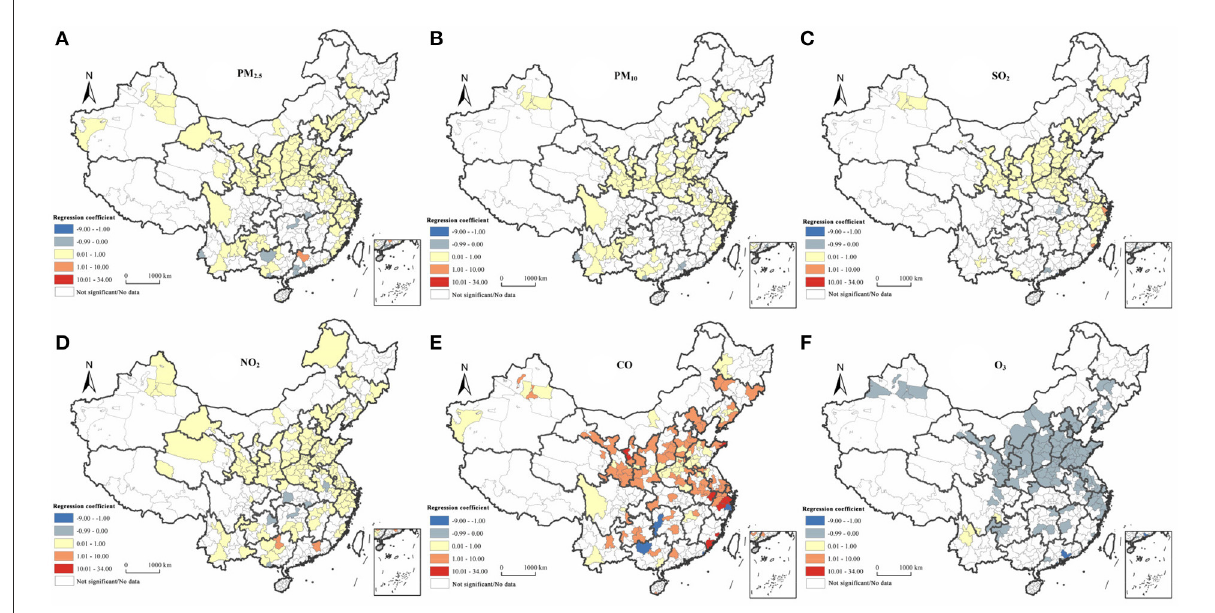
FIGURE5 The spatial distribution of regression coefficients between the influenza incidence and six types of air pollutants in China during the period 2014-2017. (A) PM 2.5 . (B) PM 10 . (C) SO 2 . (D) NO 2 . (E) CO. (F) O 3